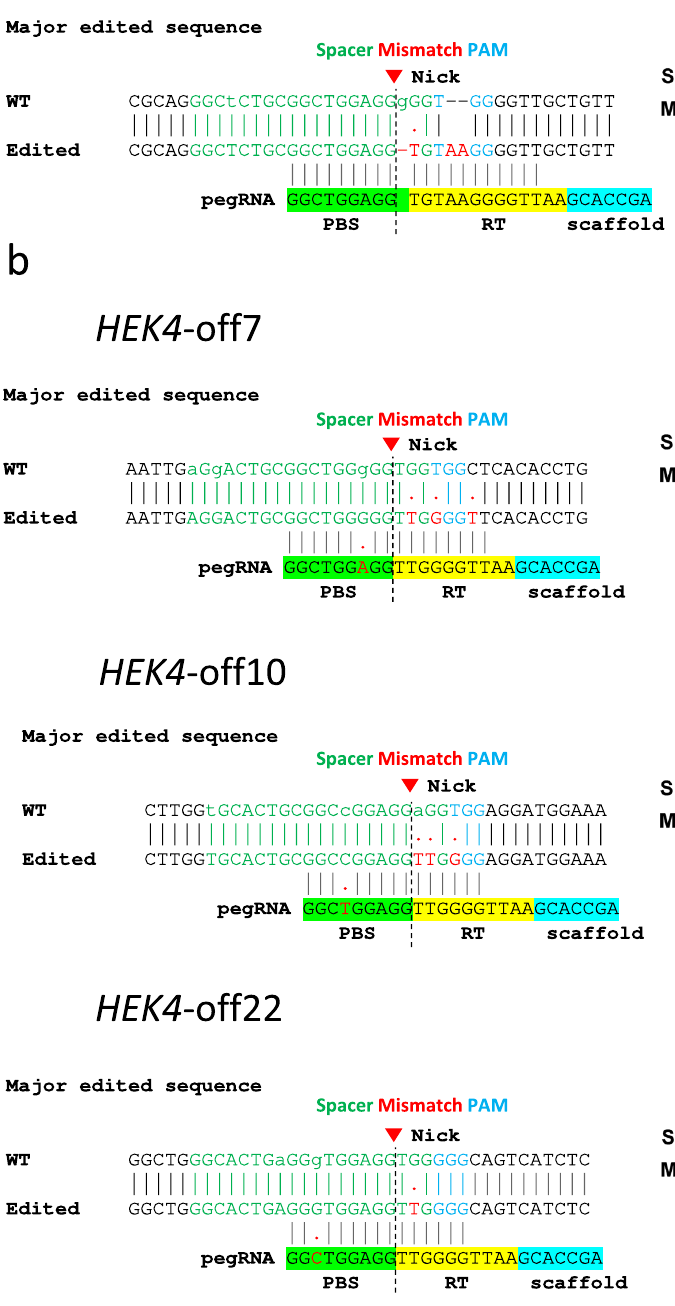
control. The bars represent the mean. Error bars indicate standard deviation ( n =3 independent transfection). Small letters indicate mismatches compared to the pegRNA. Major edited rate corresponds to the frequency of the ‘ Edited ’